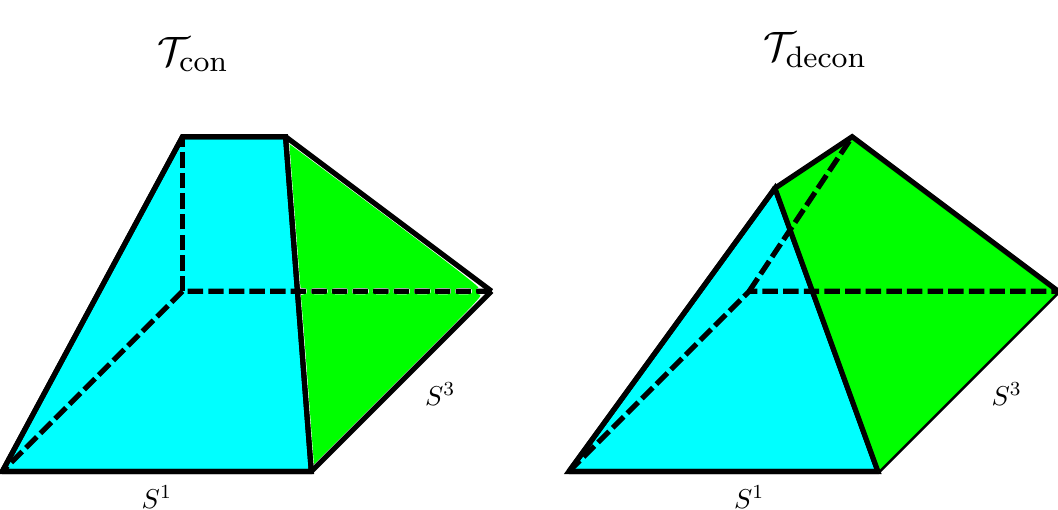
Figure 1 . Geometrical phases in global EAdS 5 : the cyan face represents Euclidean time direction S 1 , compactified with the period 1 , the green face represents the 3-sphere S 3 . The bulk geometry T with the S 3 smoothly shrinking to zero size represents the confined phase of thermal (the left panel). The bulk geometry with the S 1 smoothly shrinking to zero size represents the deconfined phase of thermal = 4 SYM (the right panel). N